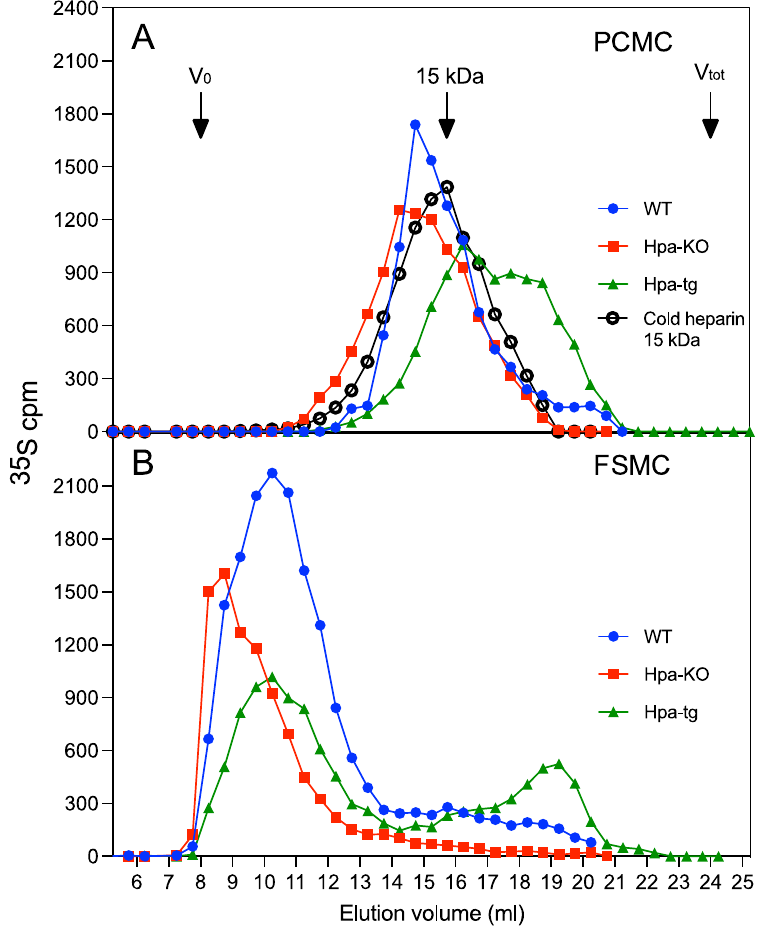
Figure 1. Differential heparin chain length in FSMC and PCMC. Metabolically 35 S-labeled heparins isolated from PCMC ( A ) and FSMC ( B ) were analyzed on Superose-6 column. Blue circles : WT; red squares : Hpa-KO; green triangles : Hpa-Tg. Unlabeled commercial 15 kDa heparin ( empty circles ) was analyzed as an internal control. For each genotype the experiment was conducted at three cultivation times performing analytical duplicates. The whole experiment was repeated two times with similar results.